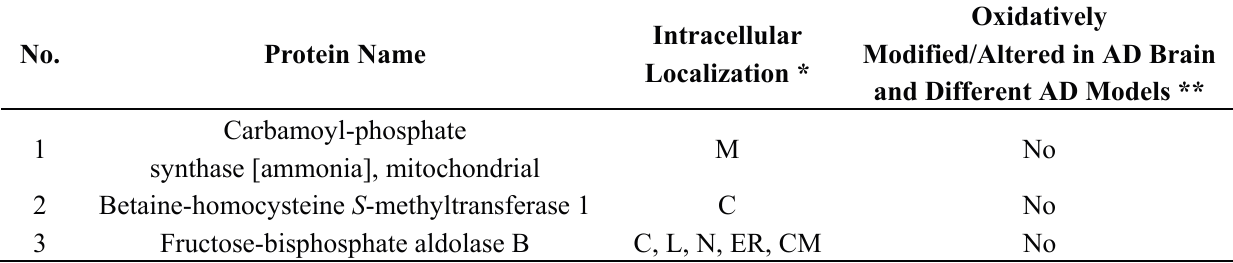
Table 2. Common amyloid-binding proteins for all experimental groups.